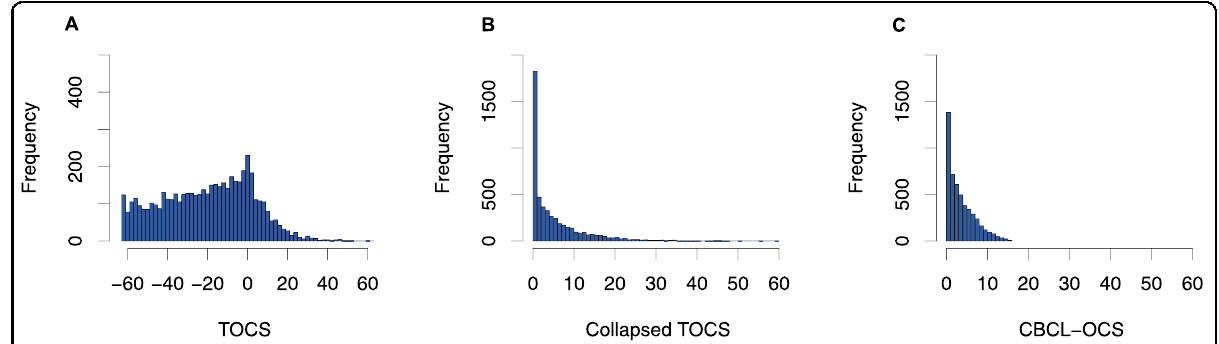
Fig. 1 Distribution of OC trait measures. Histograms of A Toronto Obsessive-Compulsive Scale (TOCS) total score, B total score for collapsed TOCS items (all negative scores converted to zero for each item) and C the Child Behavior Checklist – Obsessive-Compulsive Scale (CBCL-OCS). n =